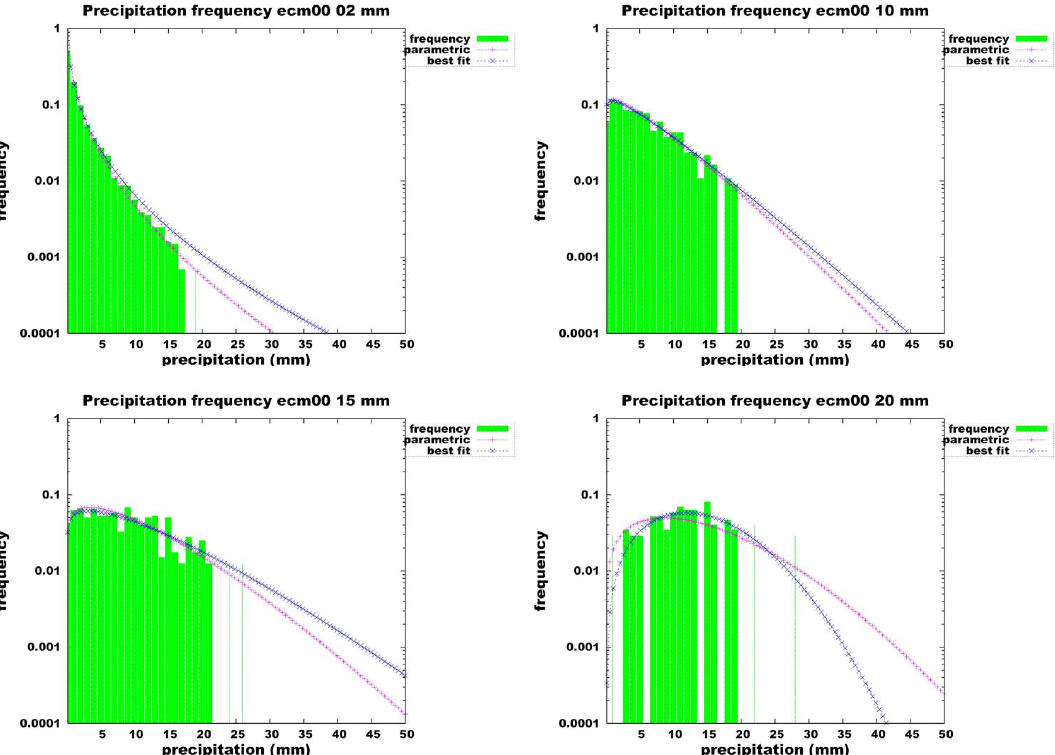
Fig. 3. Examples of conditioned PDF for the average precipitation over the warning areas (see Fig. 1) for ECMWF IFS run 00:00UTC. From top left to bottom right: 2mm, 10mm, 15mm, 25mm forecasts. Pink line: Weibull distribution evaluated from distribution moments; blue line: best fit with a Weibull distribution (see text for